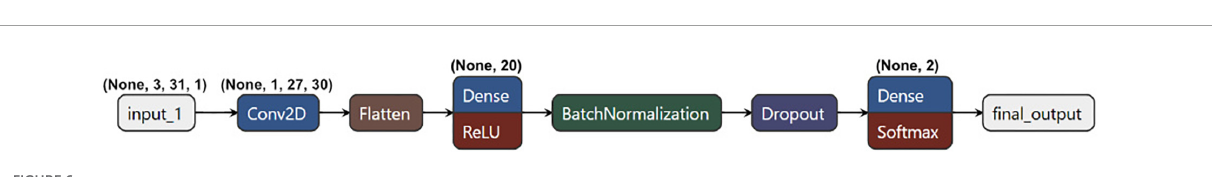
FIGURE6 Diagram of the NN3 model architecture, which consists of a Conv2D layer, a flatten layer, a Dense layer and ReLU activation, along with Batch Normalization and Dropout layers.